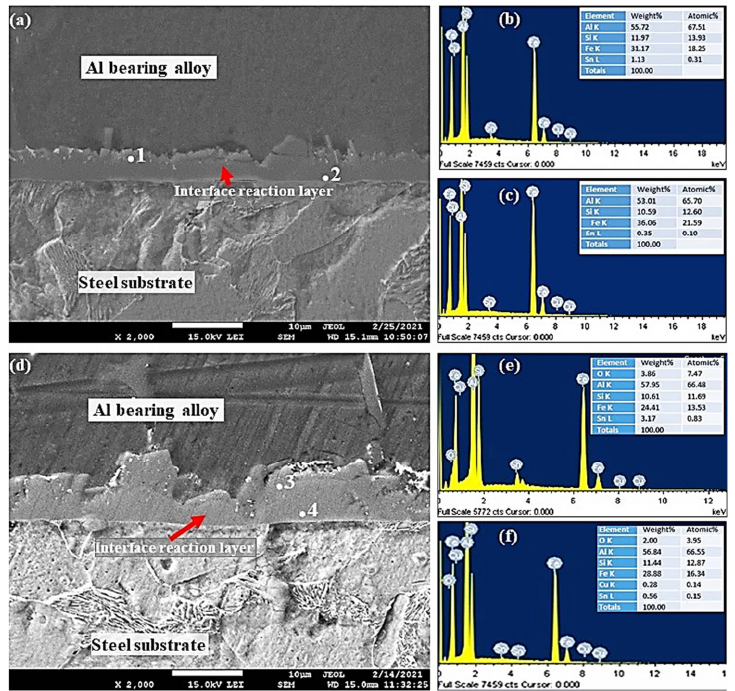
Figure 10. SEM micrographs and EDS from Al-bearing alloy/steel bimetallic composites: ( a ) SEM for bimetal with Sn interlayer (specimen 0); ( b , c ) EDS analysis of points 1 and 2 in ( a ), respectively; ( d ) SEM for bimetal with Sn + 0.25% Al 2 O 3 nanoparticles interlayer (specimen 1); ( e , f ) EDS analysis of points 3 and 4 in ( d ), respectively.